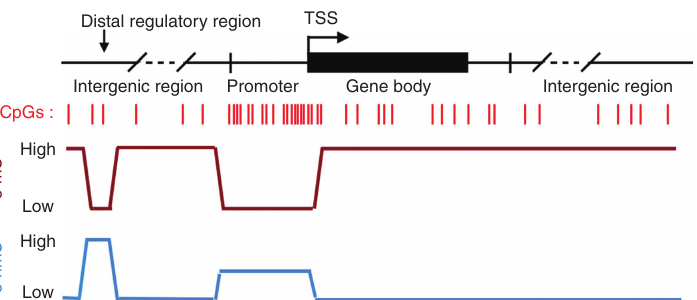
Figure 2 A diagrammatic representation of CpG sites and the status of methylated CpG (5mC) and hydroxymethylated CpG (5hmC) on different locations (promoter, intergenic, and gene body) of a